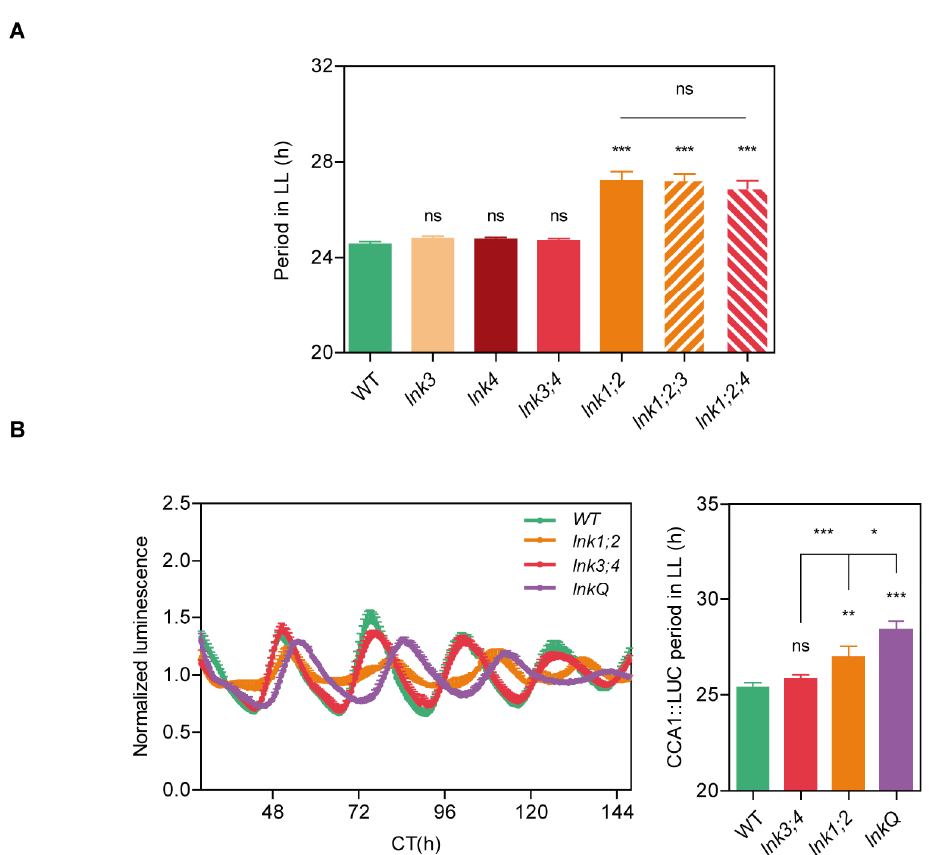
Figure 1. The NIGHT LIGHT–INDUCIBLE AND CLOCK-REGULATED (LNK) family exhibits partial redundancy in the control of circadian rhythms. ( a ) Circadian rhythms of leaf movement in continuous light (LL), after entrainment under long-day conditions. ( b ) CCA1 ::LUC activity measured for 5 days in LL, after entrainment under long-day conditions. Bioluminescence was recorded every 2 h over 6 days. Periods of circadian rhythms in leaf movement and CCA1 ::LUC activity were estimated with BRASS 3.0 software (Biological Rhythms Analysis Software System). Error bars indicate standard error of the mean (SEM). Student’s t -test was performed between mutants and wild-type (WT) (*: significantly different, p ≤ 0.05; **: significantly different, p ≤ 0.01; ***: significantly different, p ≤ 0.001; ns: not